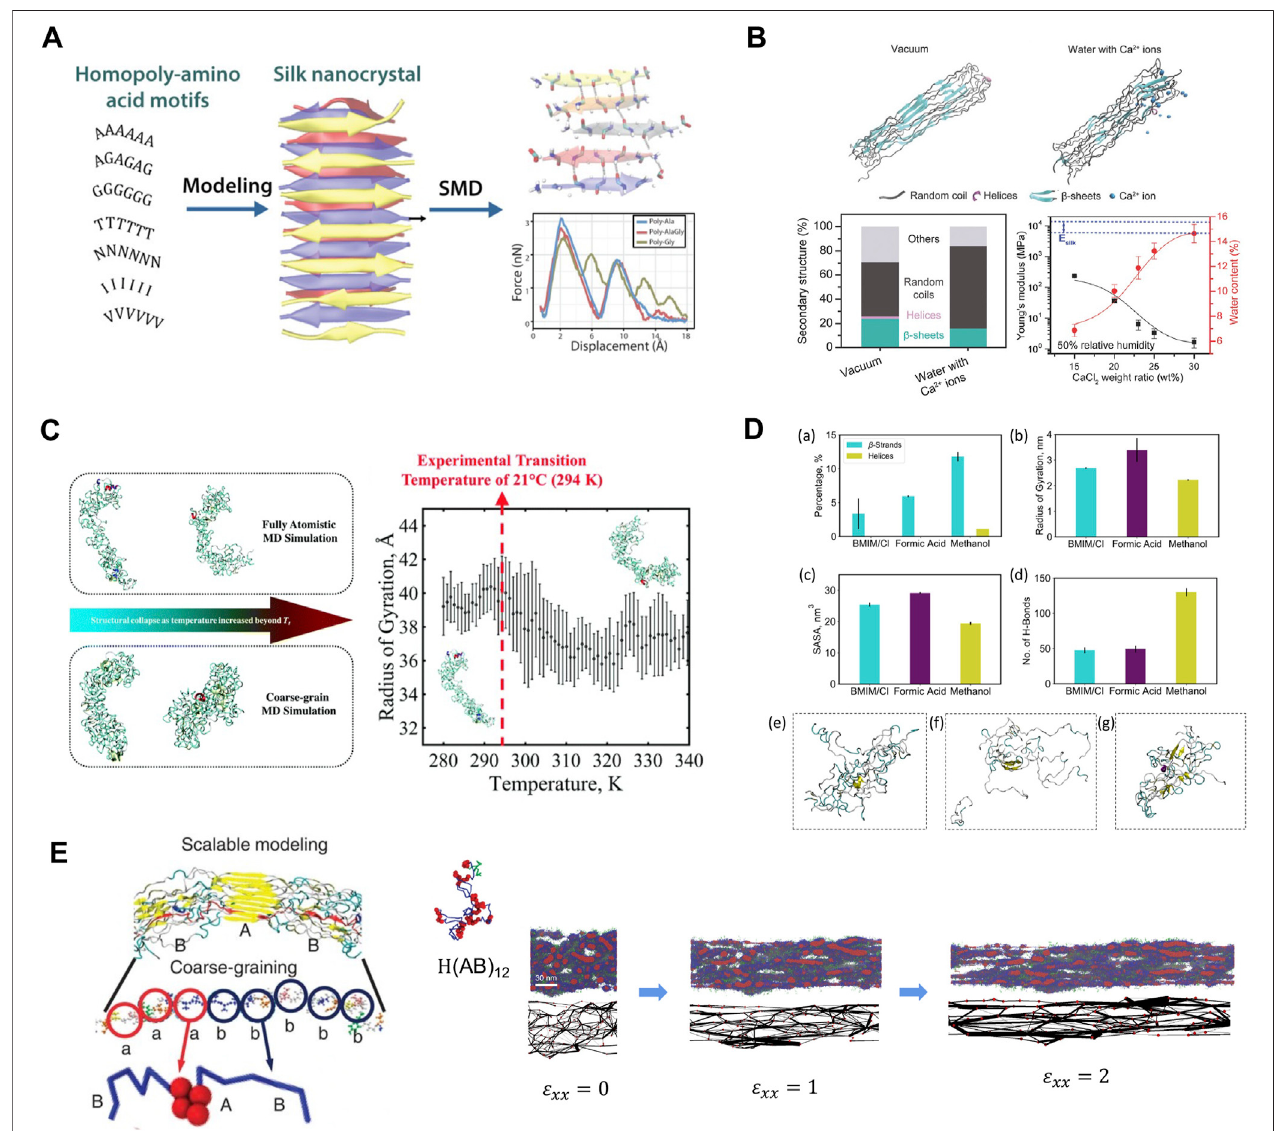
FIGURE 4 | Multiscale modeling facilitates the design of new silks. (A) Models of β -sheet nanocrystals with various representative small/polar/hydrophobic amino acidrepeats. Simulation results showed thathomopolymers ofalanineand alanine – glycinesequencemotifs havebetternanomechanicalproperties than othermodeled structures. Adapted with permission from ref (Verma et al., 2021). Copyright 2021 American Chemical Society. (B) Representative snapshots of silk protein in vacuum and water with Ca 2+ ions. The secondary structures showed water and Ca 2+ ions introduce extensible structures in silk to reduce Young ’ s modulus and improve stretchability.Adaptedwithpermissionfromref(Chenetal.,2018).Copyright2018WILEY-VCH. (C) StructuralconformationsofSELPcapturedbyREMDandCGMD.A distinct structural transition temperature was captured in terms of the radius of gyration. Adapted with permission from ref (Yeo et al., 2018). Copyright 2018 Royal Society of Chemistry. (D) REMD simulations obtained SF structure with the in fl uence of BSEISA. Adapted with permission from ref (Shu et al., 2021). Copyright 2021 AmericanChemicalSociety. (E)